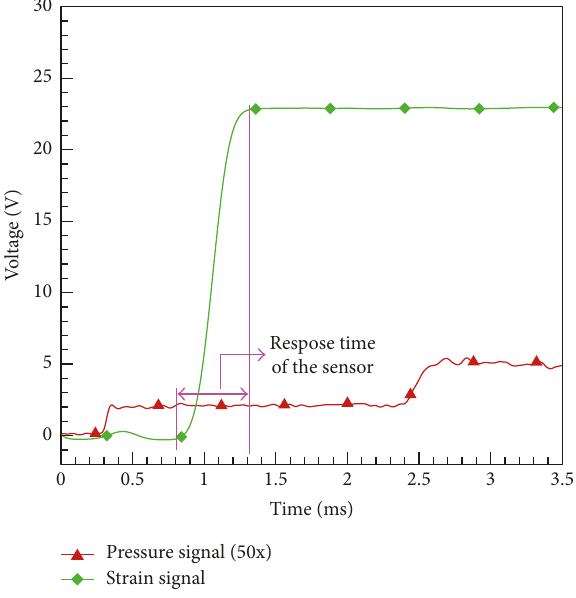
Figure 17: Obtained pressure and strain response during forming